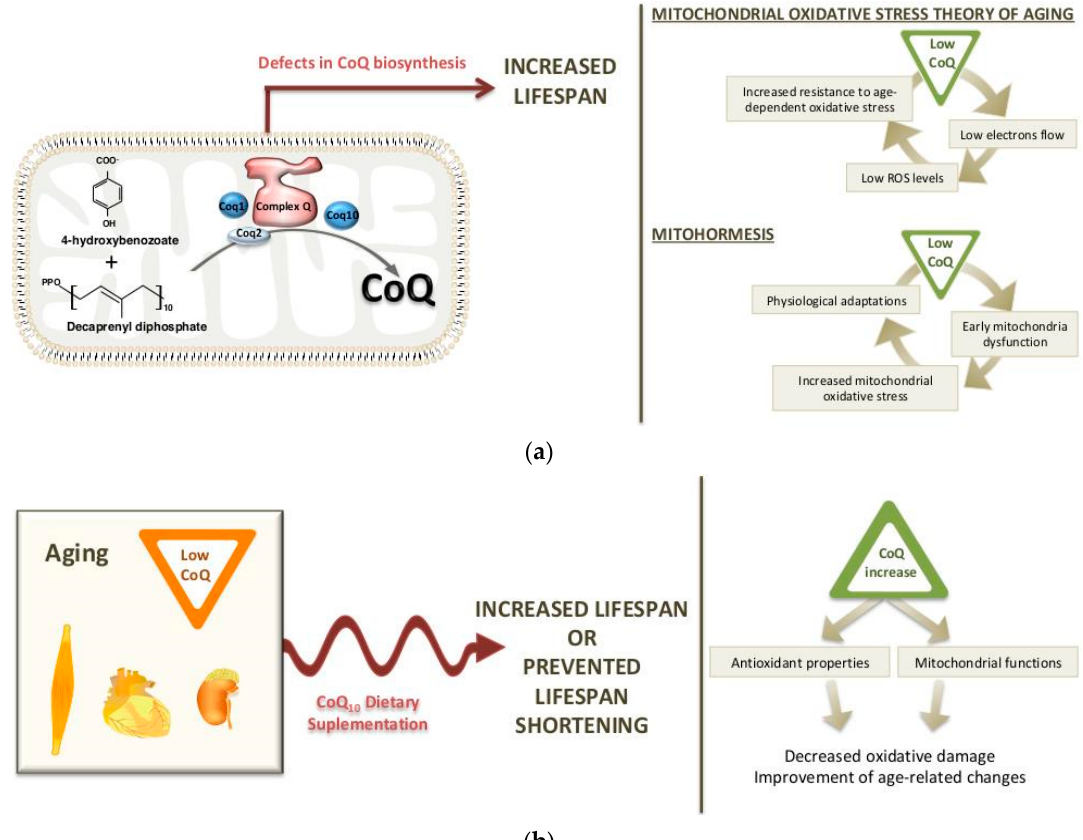
Figure 2. The role of coenzyme Q in aging: ( a ) Defects in CoQ biosynthesis cause decreased CoQ levels and increased life span, a fact that may be due to the changes in mitochondrial function and oxidative stress. ( b ) The increase in CoQ levels through CoQ10 dietary supplementation prevents some age-related damages that are associated with changes in redox states and mitochondrial function.